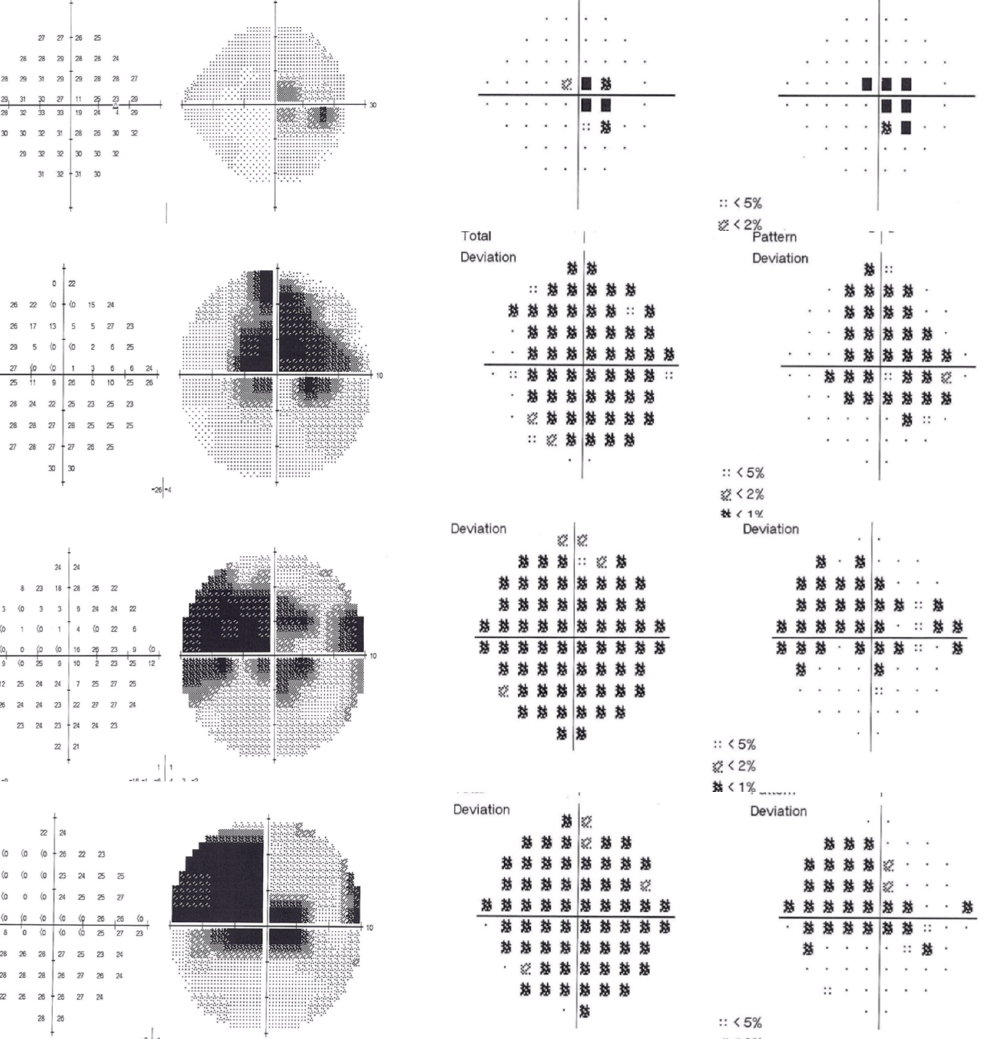
Figure 3. Sequential visual field assessment. The results were variable; however, they demonstrate a persistent but varying in shape scotoma on 10–2 central field perimetry. Subsequent carotid and vertebral artery duplex scans were unremarkable, showing minor symmetrical flow abnormalities in the internal and external carotid arteries at the bifurcation of the common carotid and normal vertebral